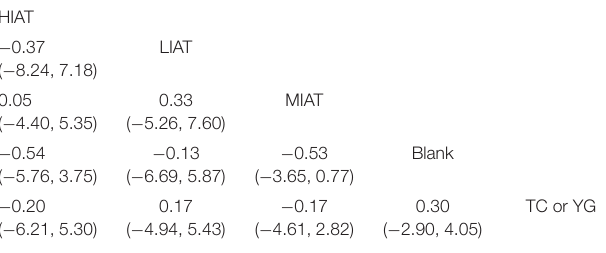
TABLE 2 | The League Table of the interventions for the malondialdehyde (MDA). HIAT